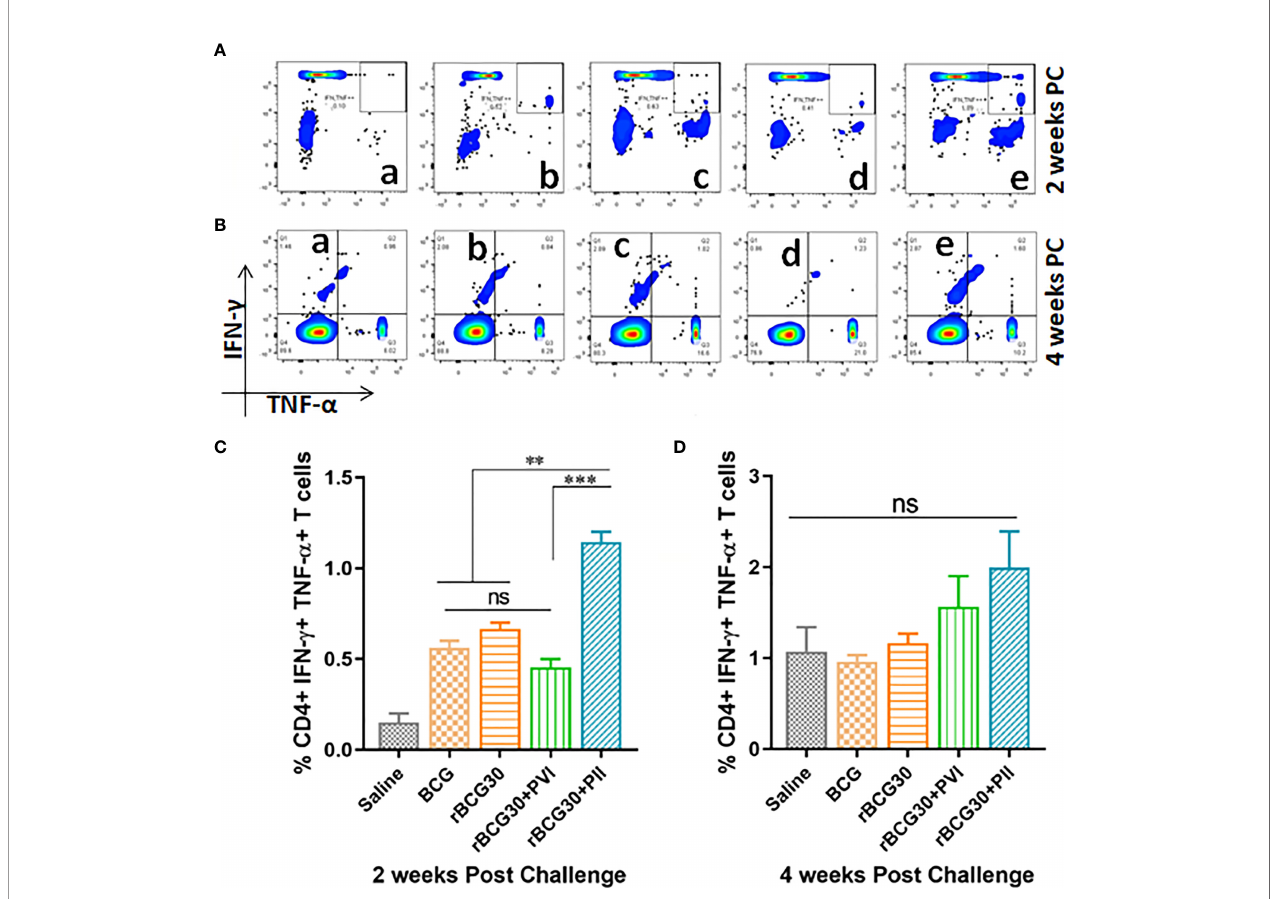
FIGURE 6 | Multifunctional CD4+ T cell response post-challenge with Mtb . Splenocytes isolated from various immunized and immunotherapy treated animals were pro fi led employing fl ow cytometry for simultaneous production of IFN- g and TNF- a by CD3+CD4+ T cells at 2 as well as 4 weeks PC. The fi gure depicts representative FACS plots of CD4+ MFTs belonging to (a) Saline, (b) BCG, (c) rBCG30, (d) rBCG30+5,15-DPP (PVI), and (e) rBCG30+5,15-DPP (PII) groups, at (A) 2 and (B) 4 weeks PC, respectively, and corresponding quantitative assessment in the form of bar graphs (C, D) . Cells were stimulated with native Ag85B antigen from Mtb (5 µg/ml). The data were analyzed using One-way ANOVA followed by Tukey ’ s multiple comparison test and are shown as the means ( ± SEM) from one of the two independent experiments with similar observations performed in at least three biological replicates, where p<0.05(*), p<0.01(**), and p<0.001(***) were considered signi fi cant. ns, non-signi fi